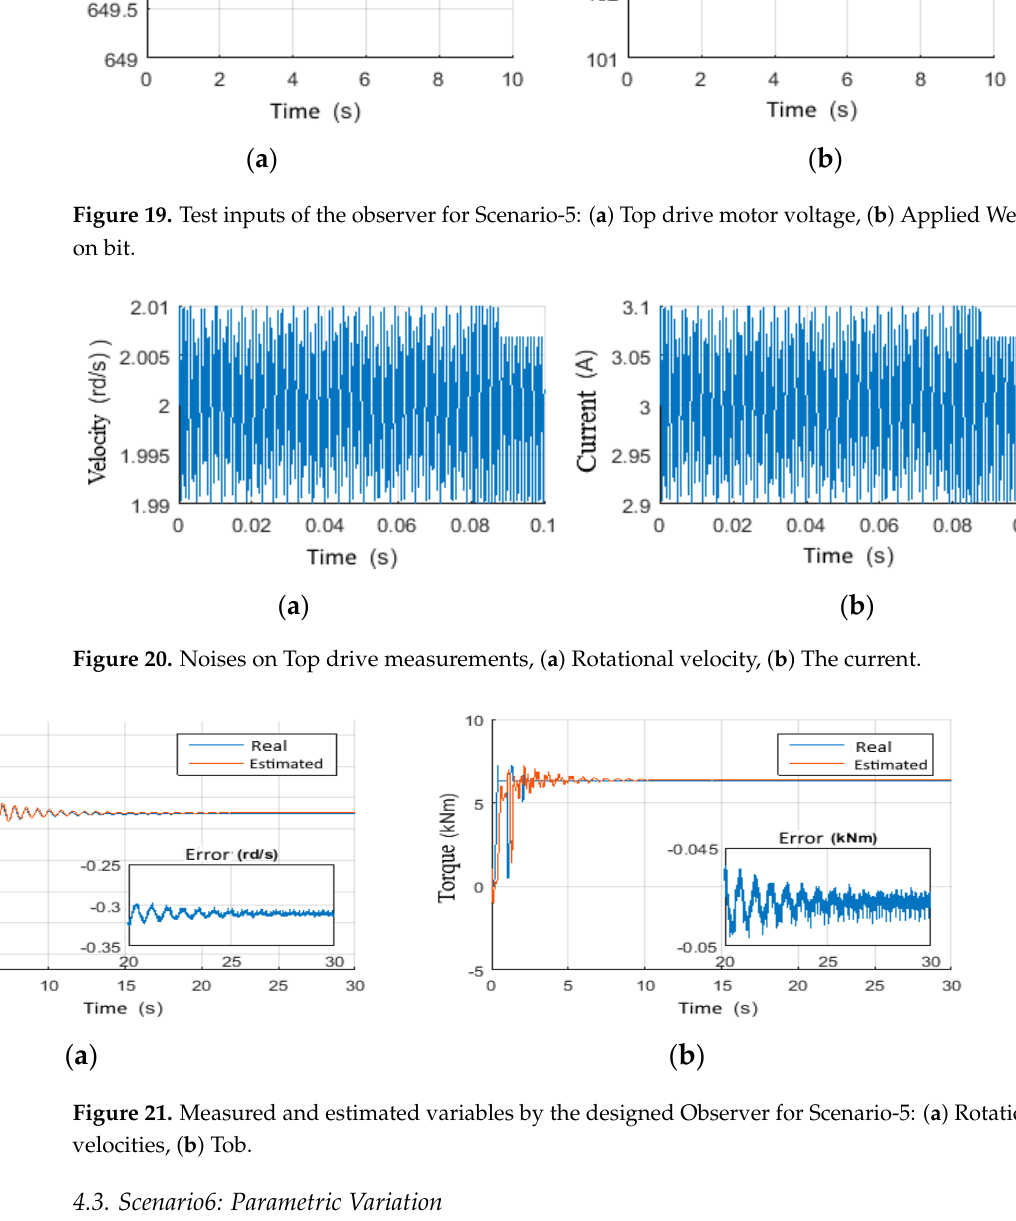
Figure 21. Measured and estimated variables by the designed Observer for Scenario-5: ( a ) Rotational velocities, ( b ) Tob.